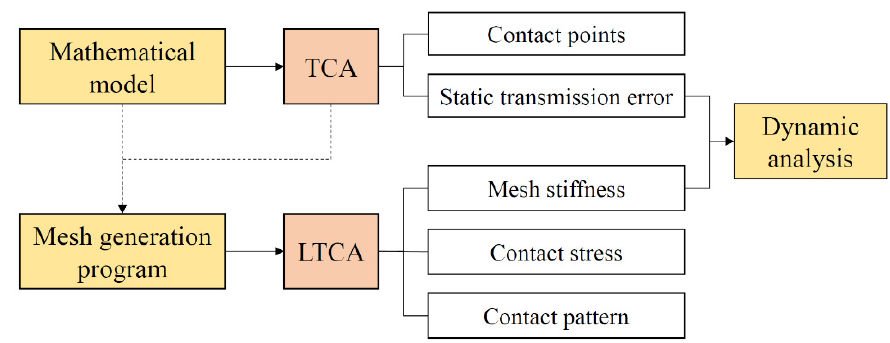
Figure 2. Flowchart of the analysis process.